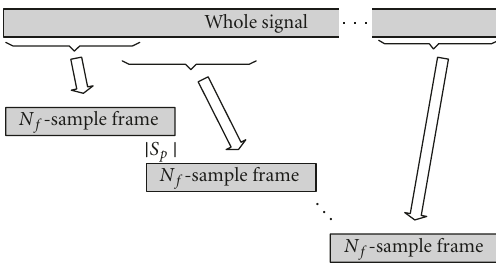
Figure 2: Division of the signal into frames.